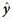
Task structure diagram.For images in the dataset, the classes and their labels and the specific samples are shuffled and randomly presented at each episode. At each time step, the input of the model is an image along with a vector which depends on the output of the previous instance. The output of the model is a one-hot vector of length k + 1, where k is the number of classes per episode. If the model requests the label of xt, it sets the final bit of the output vector to 1. Thus, the reward for this label request action is Rreq. The true label yt of image xt is then provided at the next time step along with the next image xt+1. Alternatively, if the model makes a prediction of xt, it sets one of the first k bits of the output vector, representing y^. The reward for this action is Rcor if the prediction is correct or Rinc if not. If a prediction is made at time step t, then no information regarding its true label yt is supplied at the next time step t +1.